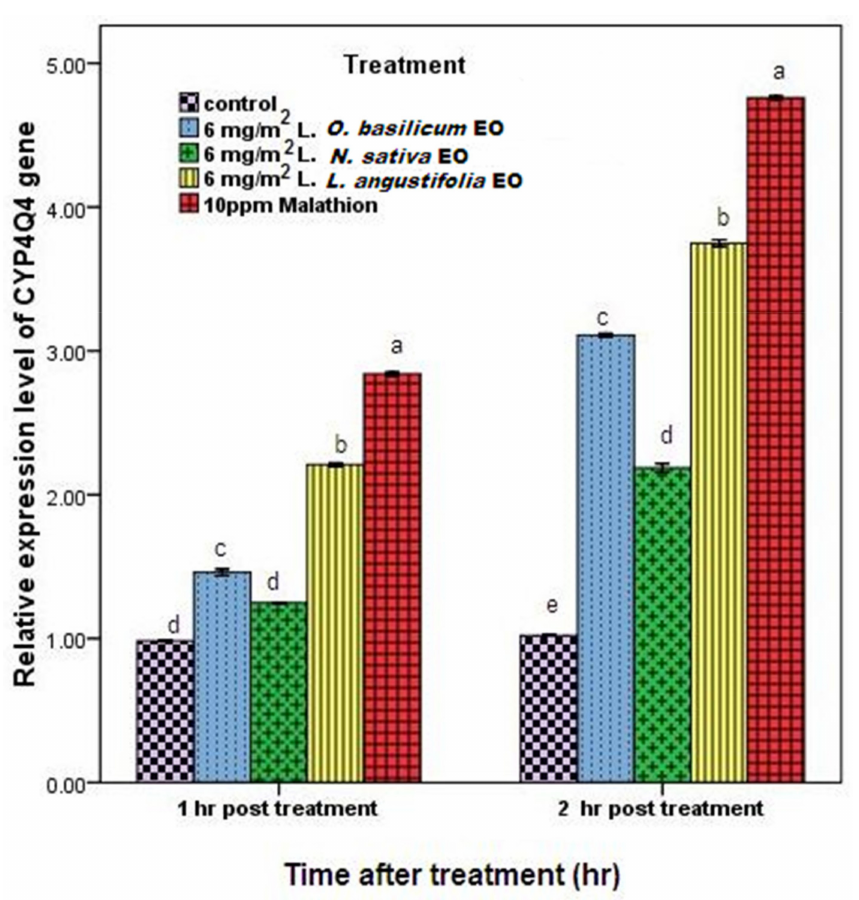
Figure 8. Relative gene expression of CYP4Q4 gene in S. oryzae adults after 1 and 2 h treated with 6 mg/cm 2 of O. basilicum, N. sativa and L. angustifolia EOs (mean ± SD) compared with standard chemical insecticide (10 ppm malathion). Different letters indicate significant differences between different treatments at p <